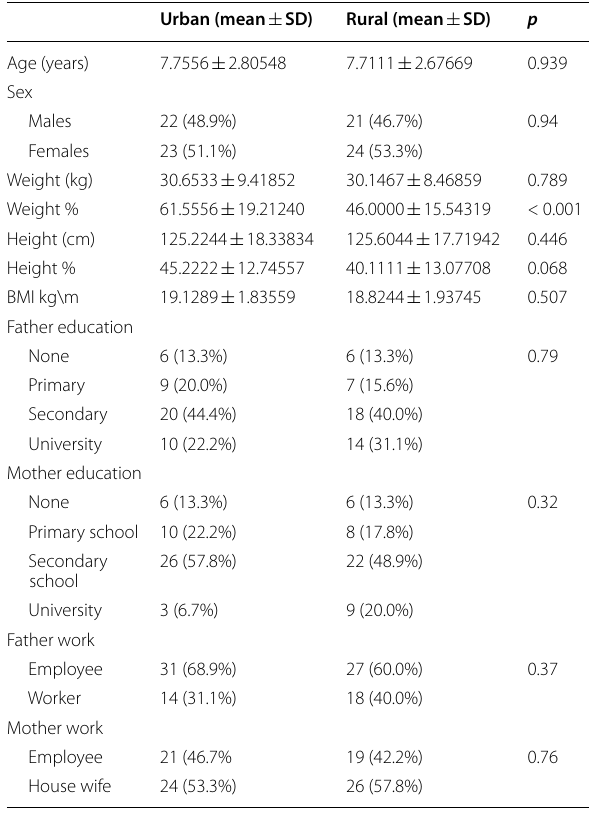
Table 1 Comparison between the urban and rural children as